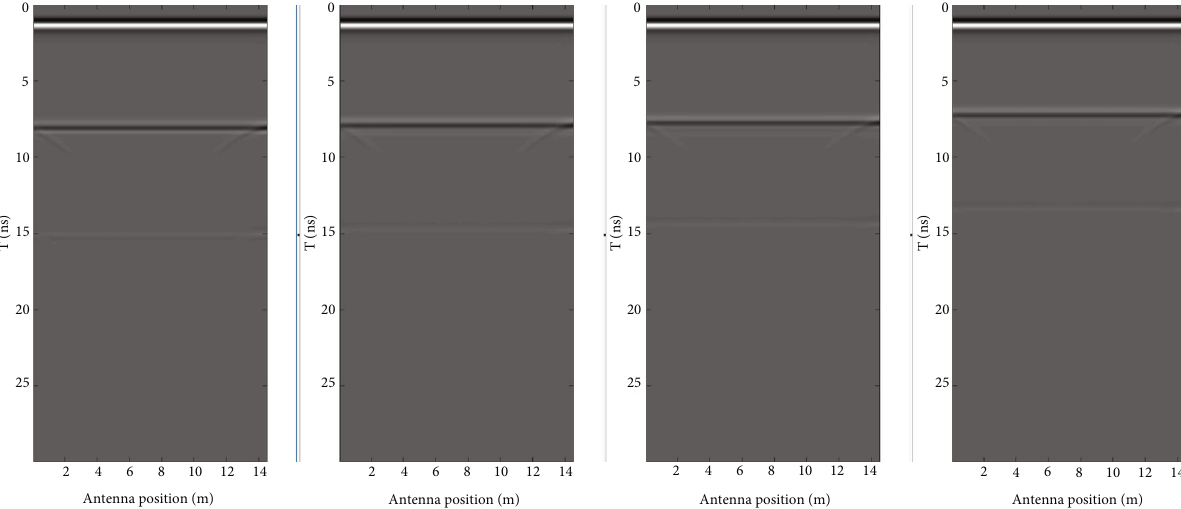
Figure 13: Gray diagram of numerical simulation of a layered object with thickness